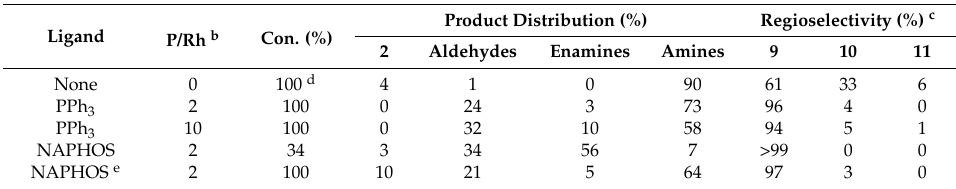
Table 1. Hydroaminomethylation of eugenol ( 1 , Figure 14) with di- n -butylamine: ligand effect a . Adapted from [79].